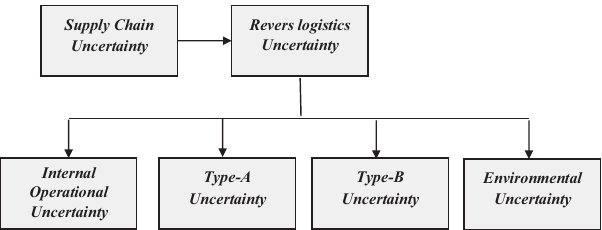
Figure 4. Taxonomy of RL uncertainty in this